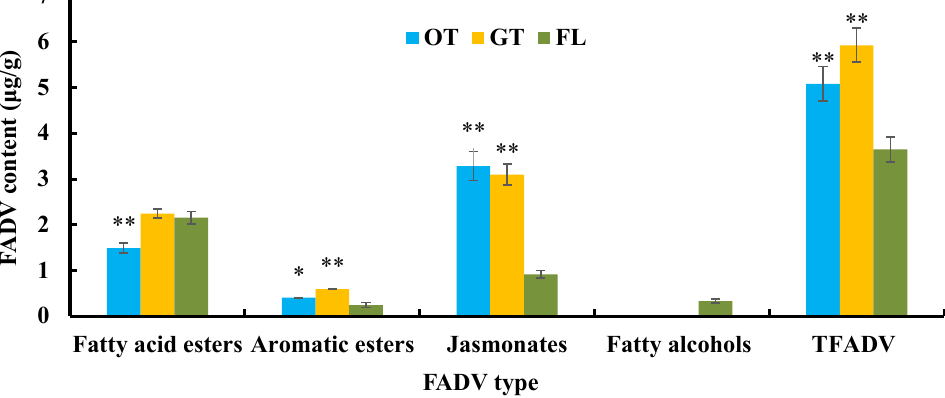
Figure 4. FADV content of different tea samples. TFADV indicates total fatty acid derivatives. * and ** indicate the difference between fresh leaves (FL) and oolong tea (OT) or green tea (GT) at p < 0.05 and p < 0.01, respectively.